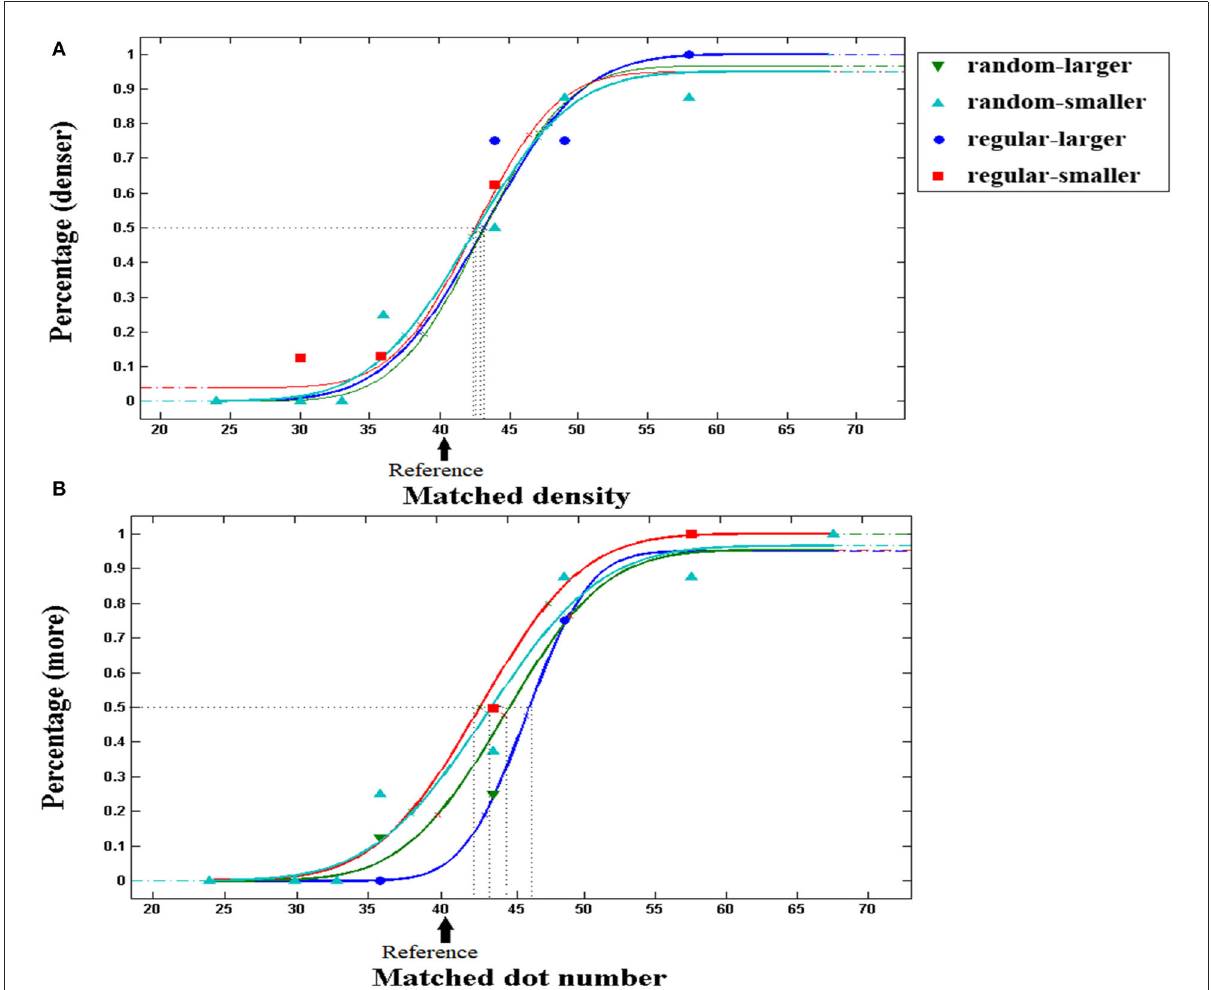
FIGURE4 Typical psychometric functions in density and number tasks. The proportion of trials in which the test patch appeared to be denser/more numerous than the reference patch was plotted as a function of the density/number of the test dots, and the vertical dashed lines show the PSE. The arrow indicates the density/number of reference dots. The participants’ typical responding curves are displayed to indicate the average PSE results. (A) Density task. (B) Number task. PSE shifts to the right in number comparison with regular patterns in perceived-larger patch (blue line), as compared with the smaller patch (red line). Note that certain fitting points were covered by others located in the neighborhood when new curves were